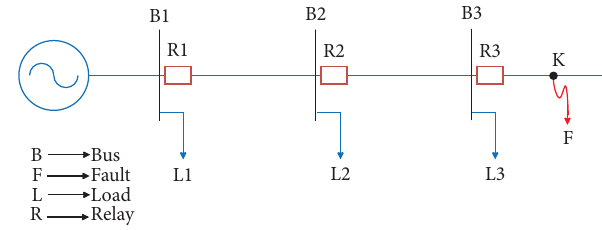
Figure 1: Radial DN with 3